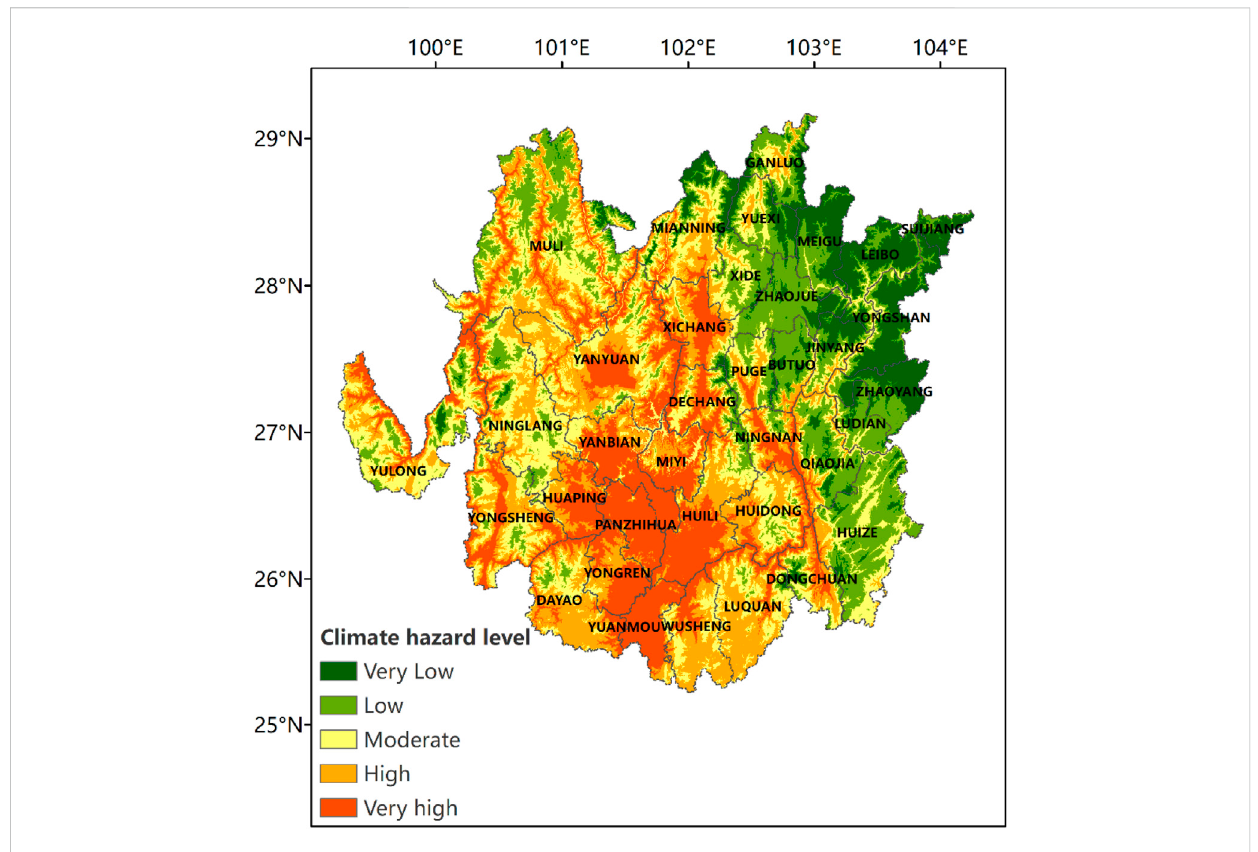
FIGURE 6 Spatial pattern of climate